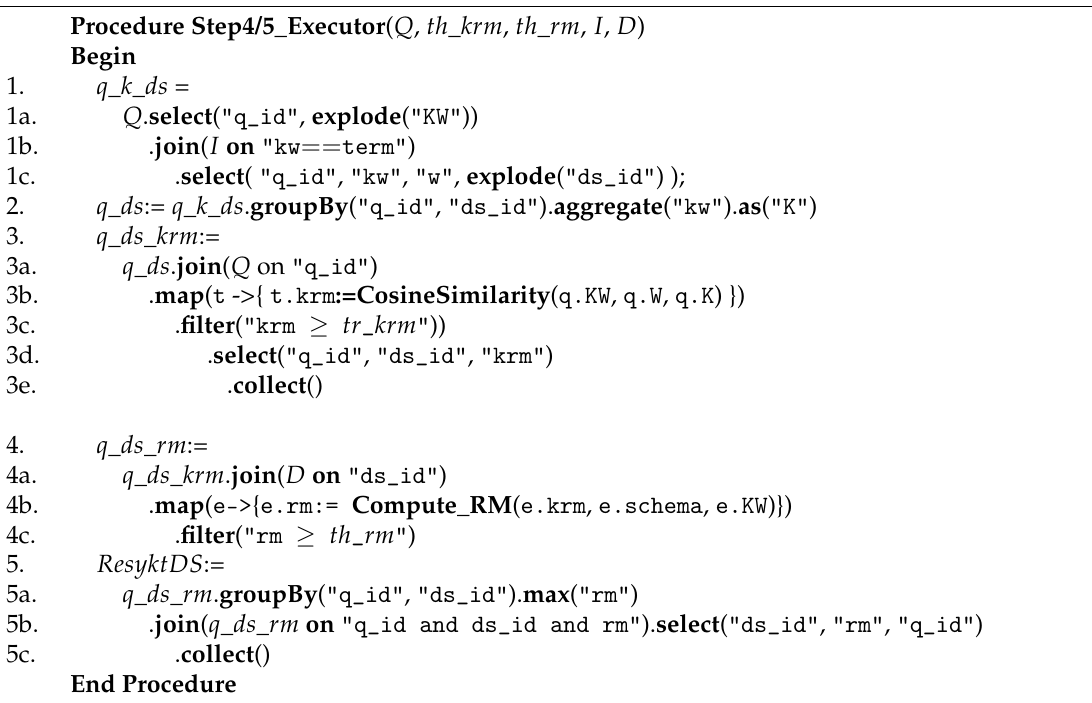
Algorithm 5: Procedure Step4/5_Executor implemented as a Spark v2